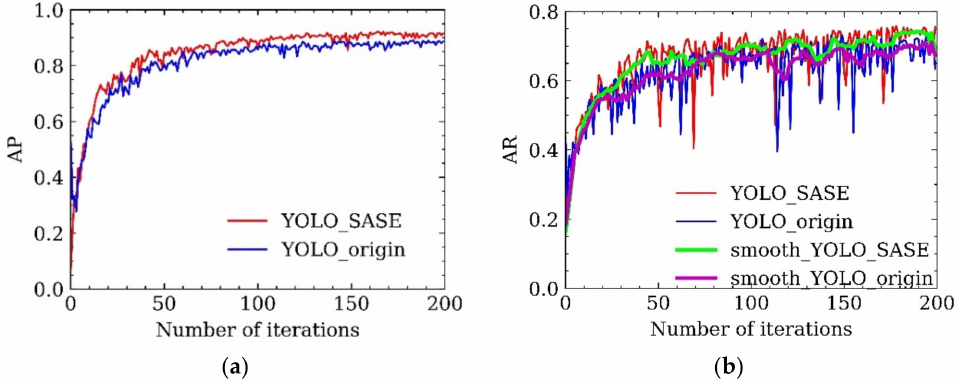
Figure 11. ( a ) accuracy comparison; ( b ) recall comparison.